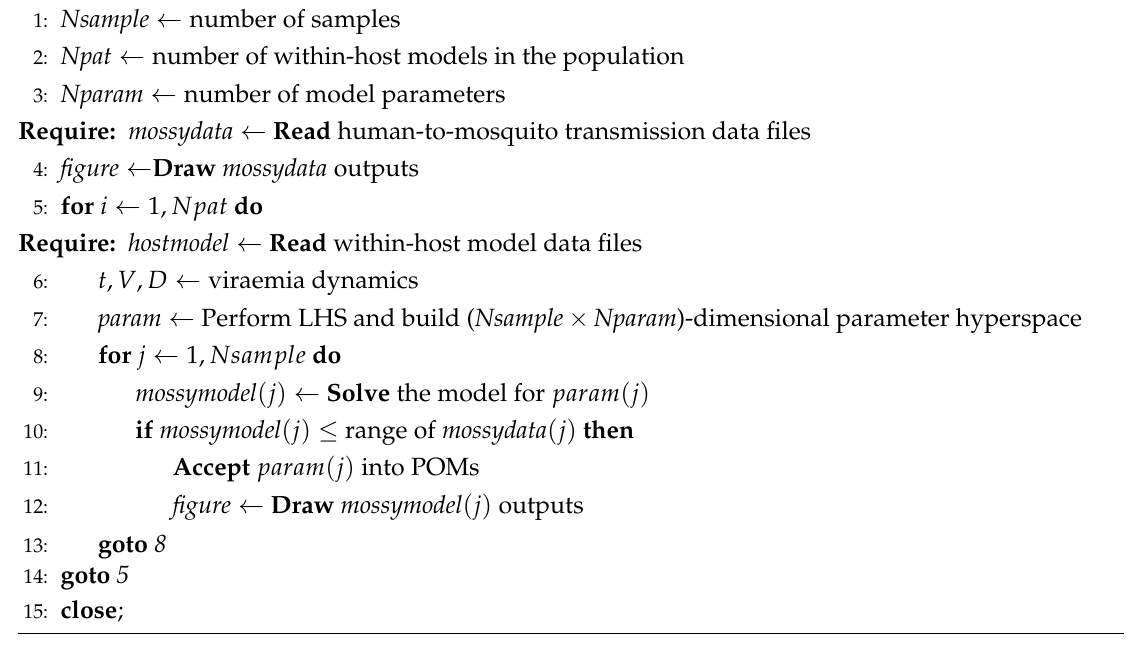
Algorithm 1 Construction of experimentally calibrated transmission POMs